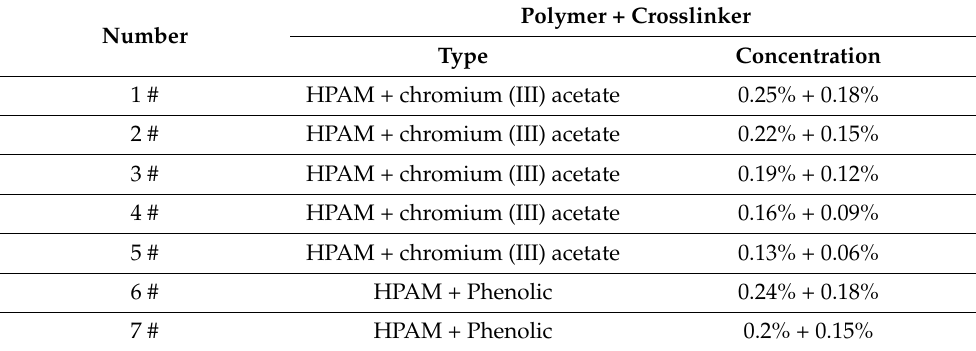
Table 2. Design of primary selection formulation.